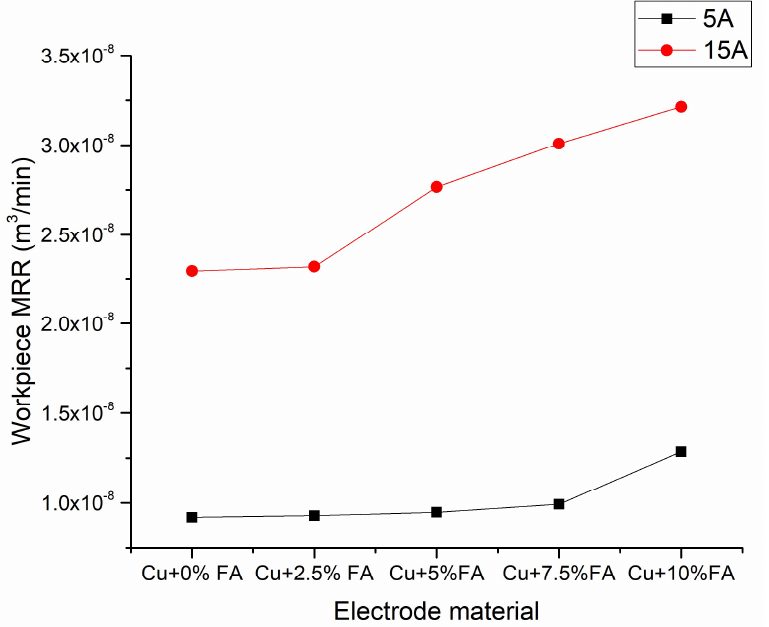
Figure 5. Effect of electrode material and current on MRR.